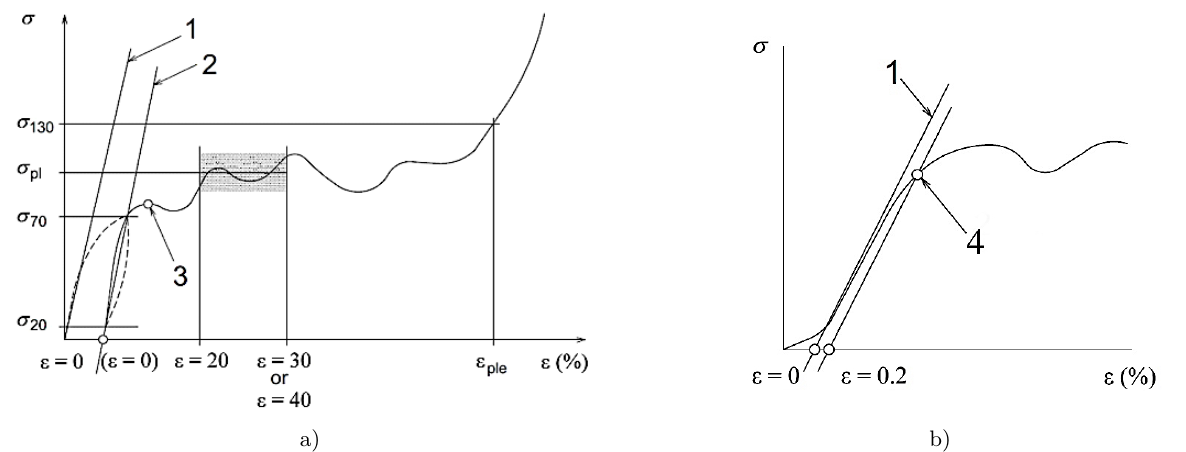
Figure 2. The stress-strain curve which is part of the standard for compression testing of porous and foam metals (ISO 13314:2011) with specific characteristics, such as 1 – quasi-static gradient, 2 – elastic gradient, 3 – the first maximum compressive strength ( σ ), 4 – the compressive offset stress ( σ 0 . 2 first,max